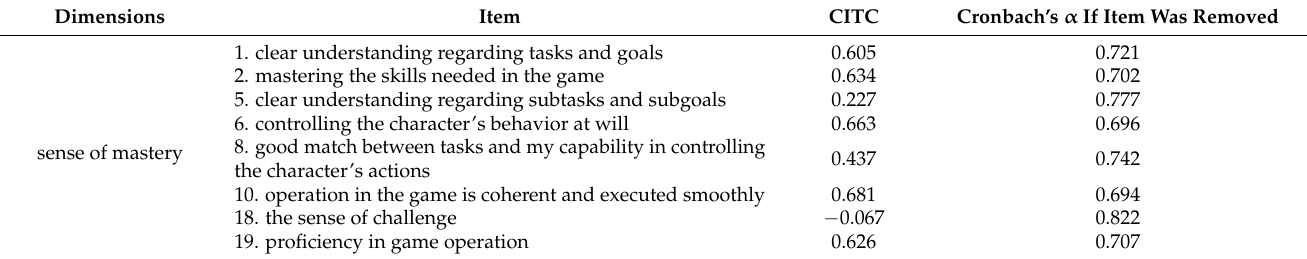
Table A1. Items and reliability metric values of different